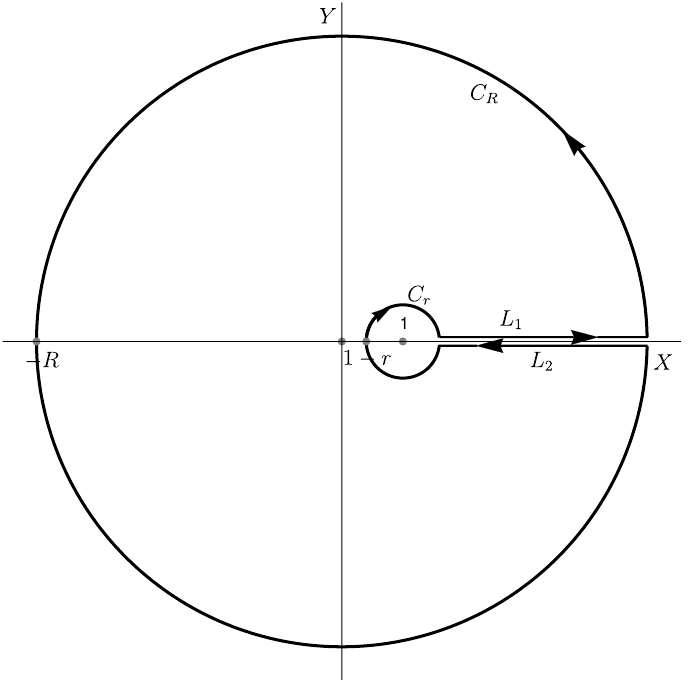
Figure 1. A contour used to derive the algorithm for computing p k given by Figure 1 A contour used to derive the algorithm for computing p